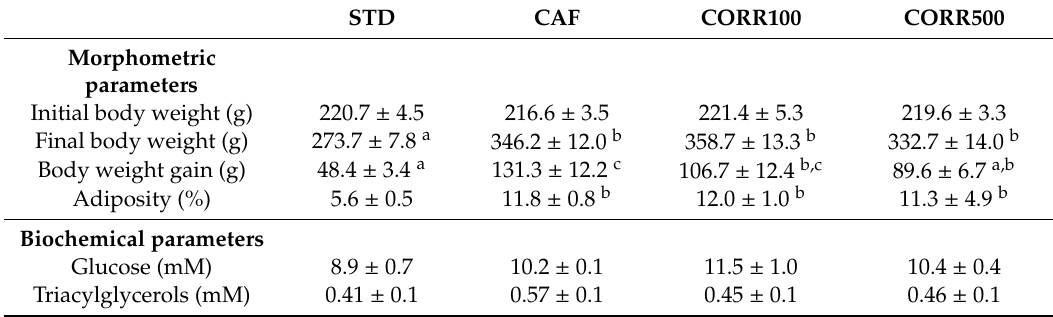
Table 2. The morphometric and biochemical parameters in experimental groups at 17